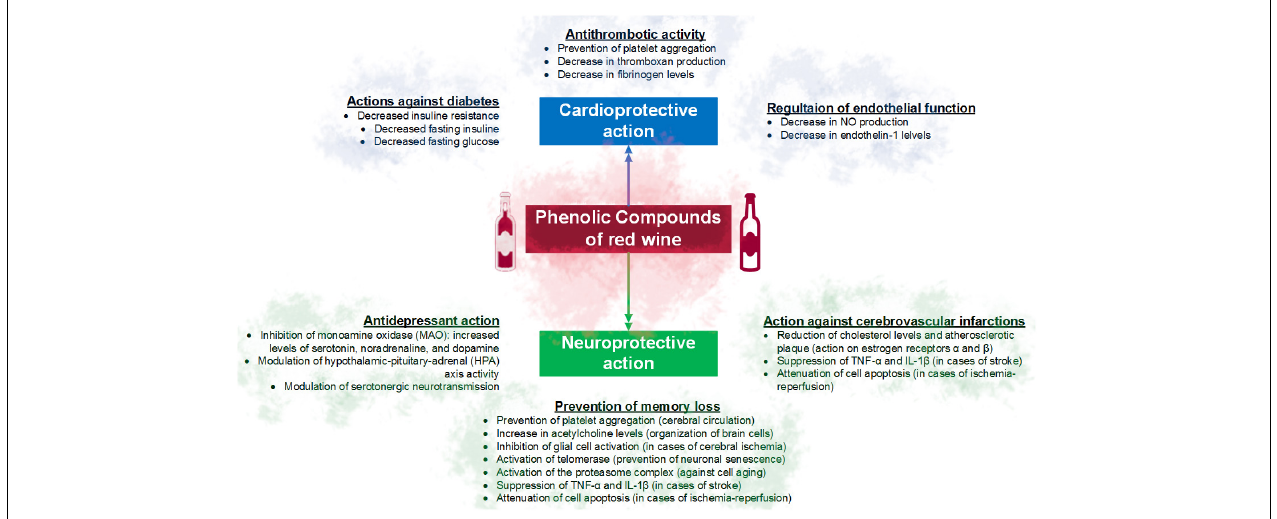
FIGURE 2 | Main cardioprotective and neuroprotective effects of the phenolic compounds of red wine.